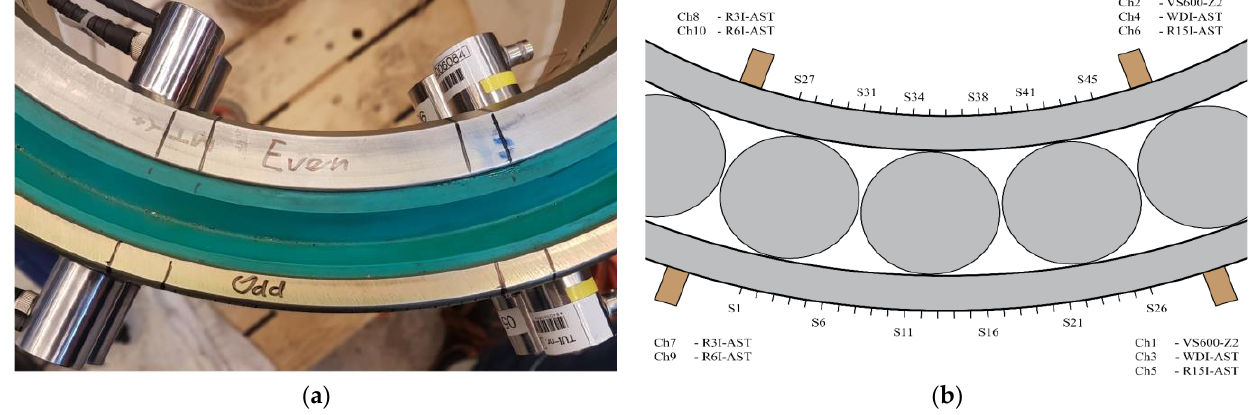
Figure 2. The top view of the experimental set-up, showing: ( a ) a picture of the instrumented bearing, and ( b ) a to-scale illustration indicating the sensor and source positions. Note that the roller positions in the illustration are purely indicative, and unknown in the actual experiment.